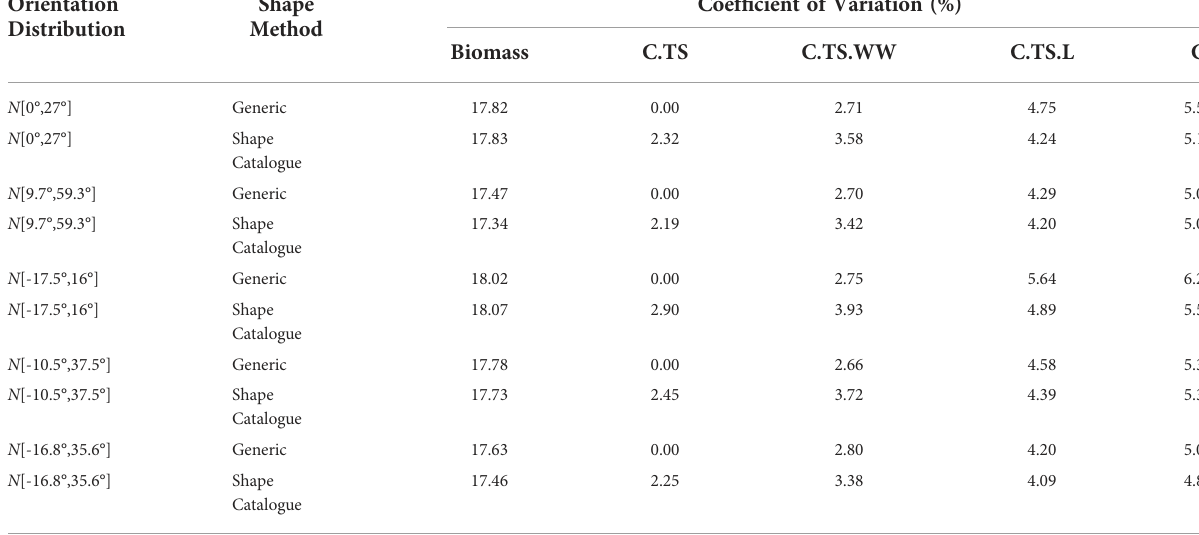
TABLE 2 Coef fi cients of variation (CV) for krill biomass and the conversion factor. Orientation